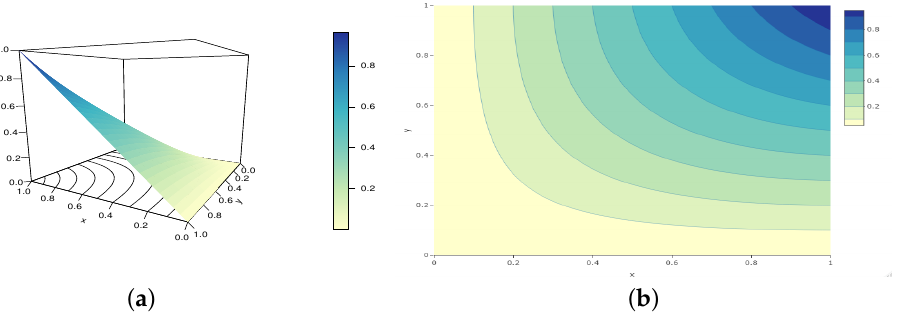
Figure 1. Illustrations of the ( a ) perspective plot and ( b ) contour plot of the GCC copula for the following configuration: a = 1/2 and b = c = 2, belonging to Configuration